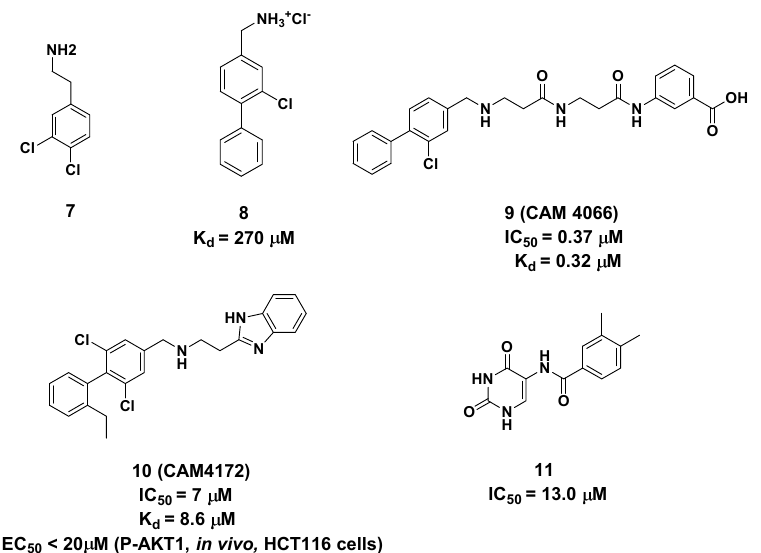
Figure 4. Structure and biological activity of compounds targeting Site 2 (K d and IC 50 values tested in vitro).